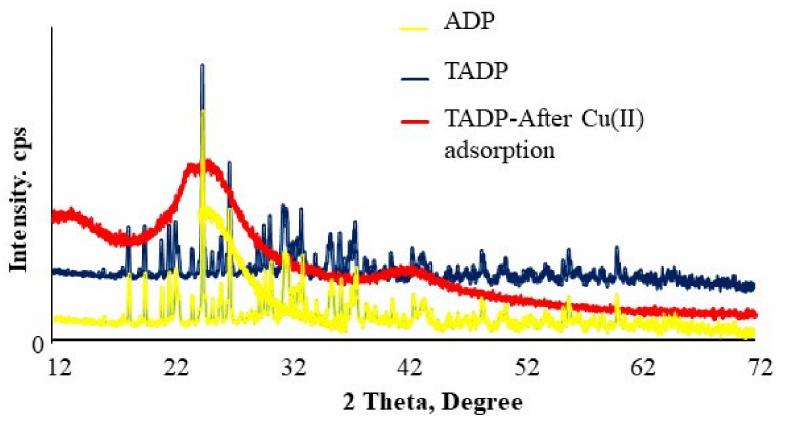
Figure 3. XRD analysis of ADP, TADP, and TADP after Cu(II)